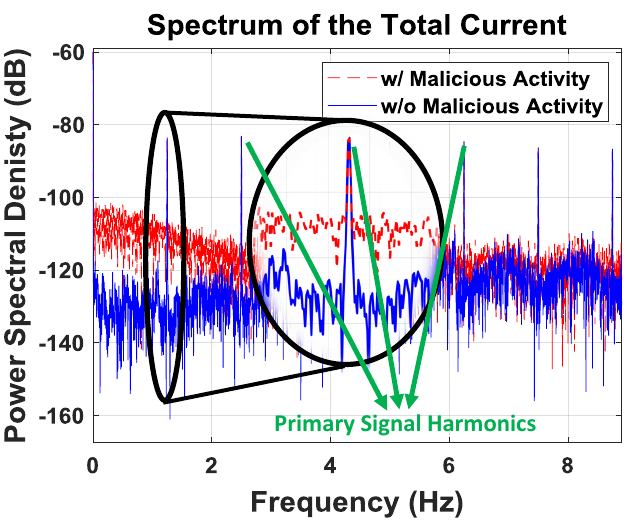
Figure 6. Spectrum of the total